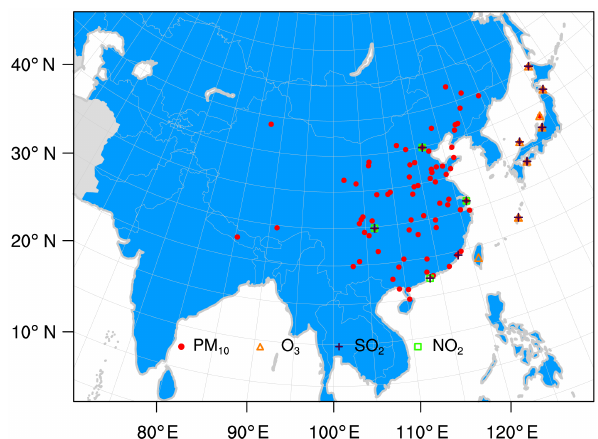
Figure 1. WRF-Chem model domain and observation sites. Blue shading indicates locations where the REAS emissions inventory is used. Gray shading indicates where the RCP8.5 emissions are used. For the entire model domain, biomass burning emissions from GFED v3 and biogenic emissions from POET v1 are used. Red- filled circles denote the observational sites with PM 10 ; orange trian- gles sites with O 3 ; purple crosses sites with SO 2 ; and green squares sites with NO 2